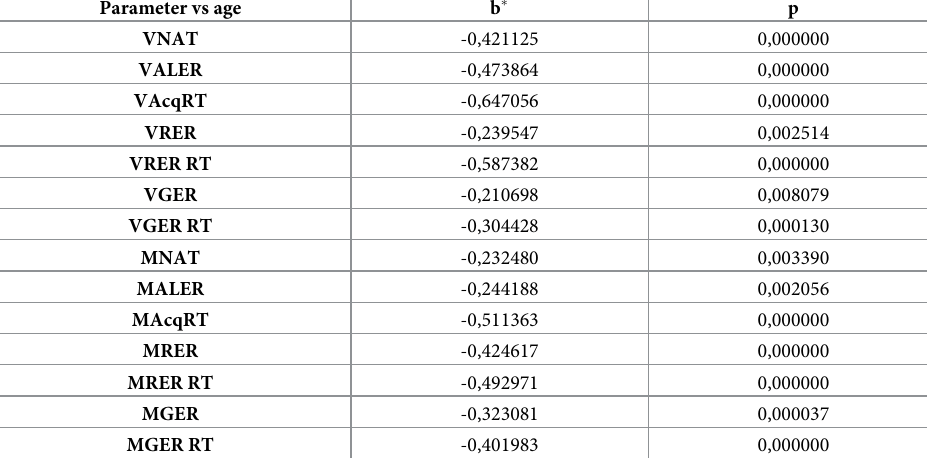
Table 2. Linear regression results of correlation between age and performance (NAT, ALER, RER, GER, RTs) in both paradigms (V: visual, M: multisensory).